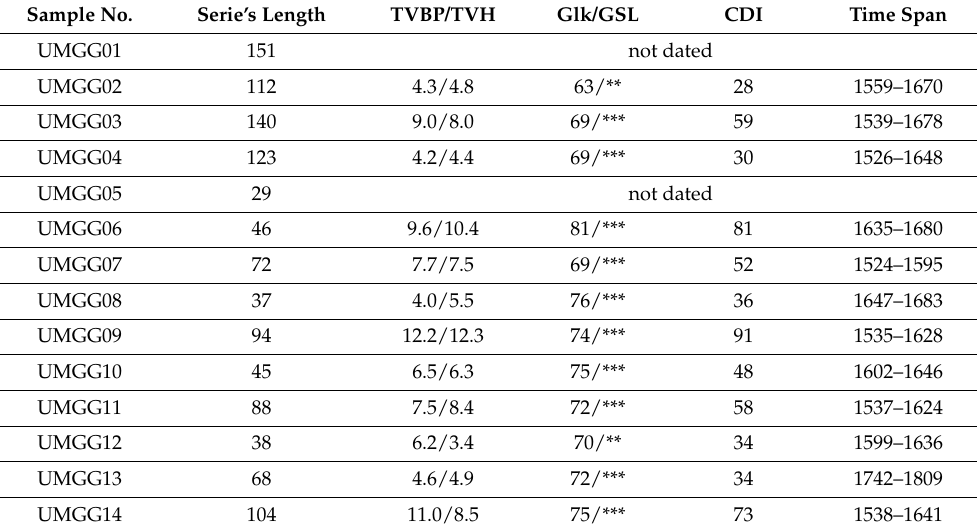
Table 4. Cross-dating results of the sequences representing samples collected in Gang Gönpa, against the Southern Mustang master chronology. The parameters used for the statistical evaluation of the cross-dating results were: Gleichläufigkeit (Glk) score; GSL; T-values: TVBP and TVH and CDI. (statistical significance of Glk ** = 99.0%, *** = 99.9%). Sample No.